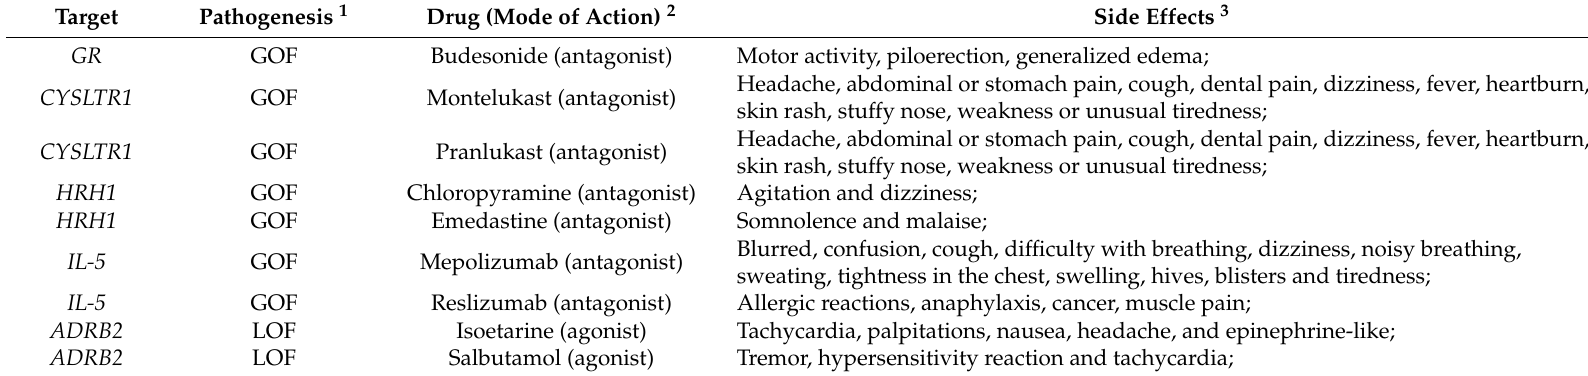
Table 2. Correspondence between target pathogenesis and drug mode of action for approved asthma-therapeutic drug.